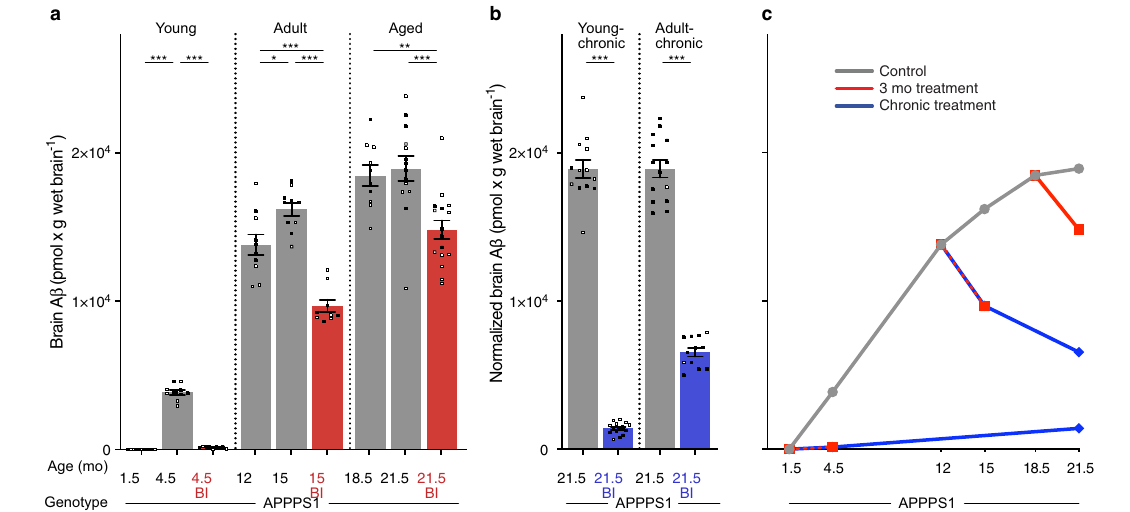
Fig. 2 | Brain A β after short-term and chronic BACE1 inhibition. Brain A β (human A β x – 40 and A β x – 42 assessed by immunoassays) in APPPS1 mice. a Brain A β at baseline and after short-termBItreatment in ‘ young ’ , ‘ adult ’ , and ‘ aged ’ mice (seeFig.1andSupplementaryFig.1afortreatmentgroupsandnumberofmiceper group). Short-term BI treatment caused a signi fi cant decrease in brain A β com- paredtotherespectiveage-matchedcontrolgroups,andwasbelowbaselineinthe ‘ adult ’ and ‘ aged ’ groups (ANOVA, ‘ young ’ : F(2, 27)=547.1; ‘ adult ’ : F(2, 26)=35.31; ‘ aged ’ : F(2, 37)=10.33, all P <0.001; post hoc Tukey ’ s multiple comparisons, * P <0.05,** P <0.01,*** P <0.001). b BrainA β levelsintheyoung-chronicand adult- chronic groups were normalized to the 21.5 mo-old control mice in the 3-month treatment group shown in a . Two-tailed unpaired t -tests revealed signi fi cantly lower brain A β levels in the BI-treated mice ( ‘ young-chronic ’ : t (26)=30.69; ‘ adult-